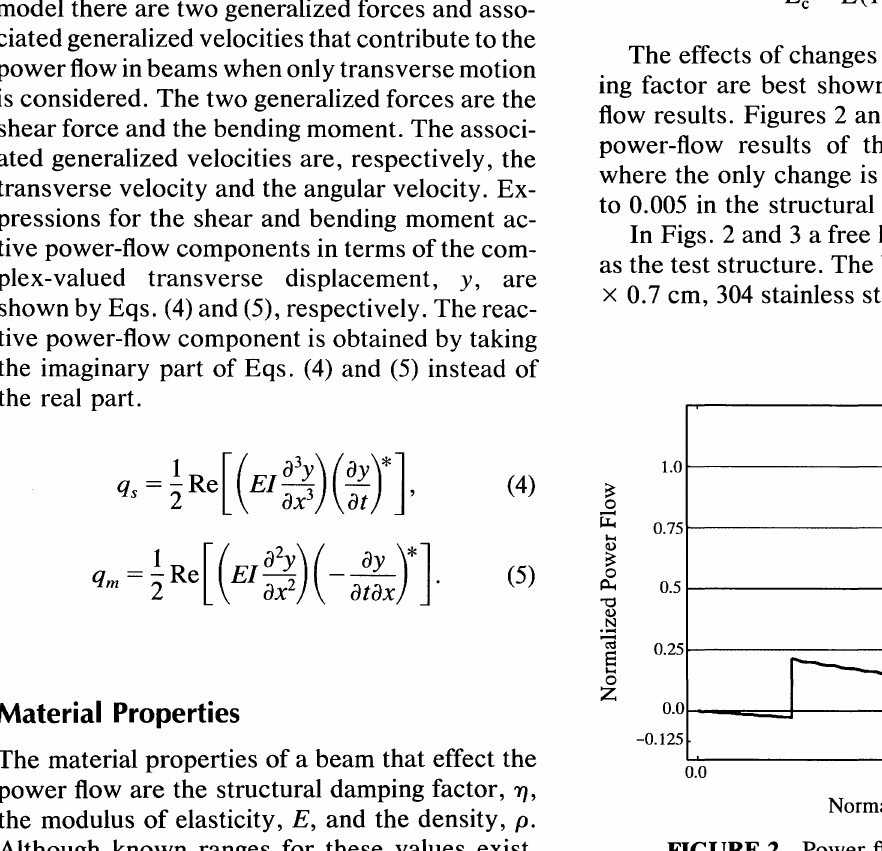
FIGURE 2 Power flow damping